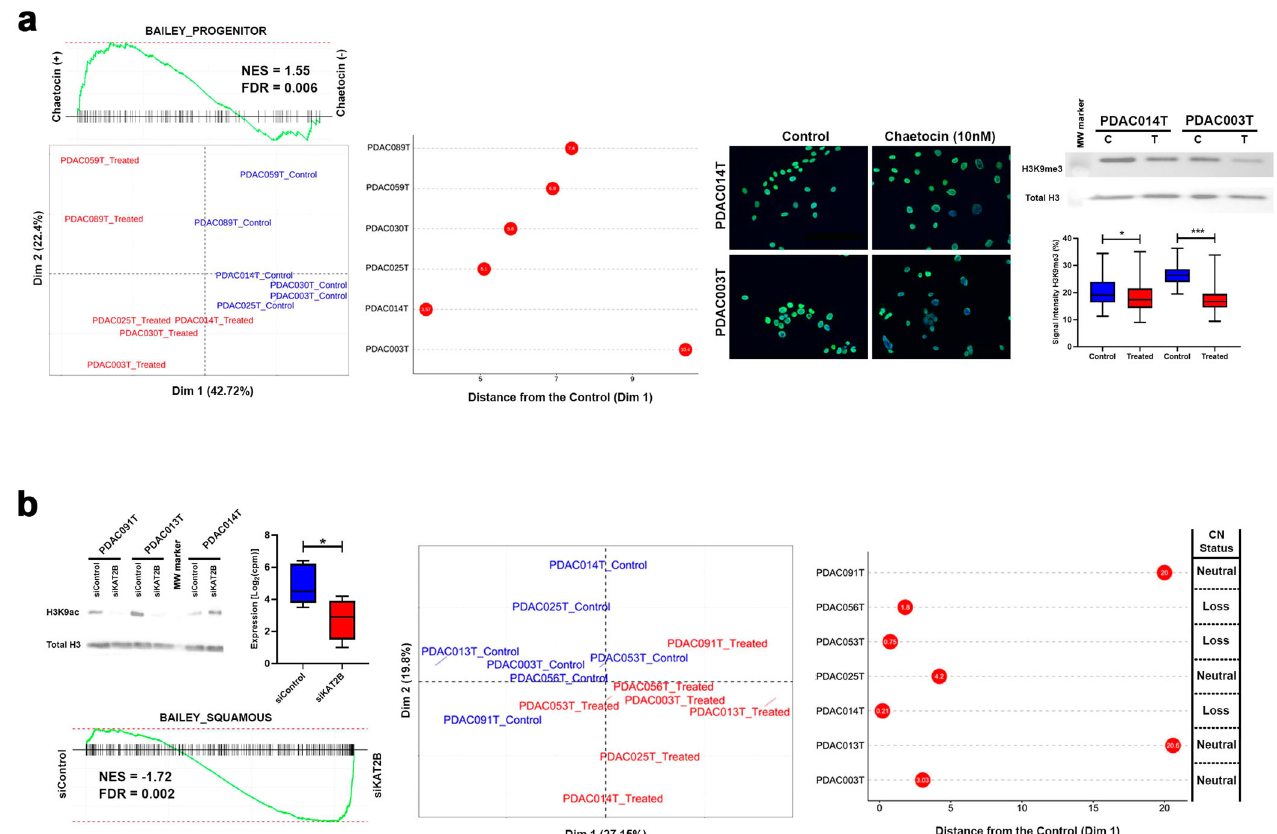
Fig. 6 Modulation of SUV39H1/H2 and KAT2B determine the PDX-Derived Primary Cell Culture (PDPCC) phenotype. a Chemical modulation of SUV39H1/H2 through chaetocin (10 nM) for 72 h lead in the activation of Progenitor-related genes. Error bars indicate mean ± SD. * P < 0.05, ** P < 0.01, *** P < 0.001. b KAT2B silencing using siRNA promotes the squamous program and was associated with the PDPCC deletion status. Error bars indicate mean ± SD. * P <